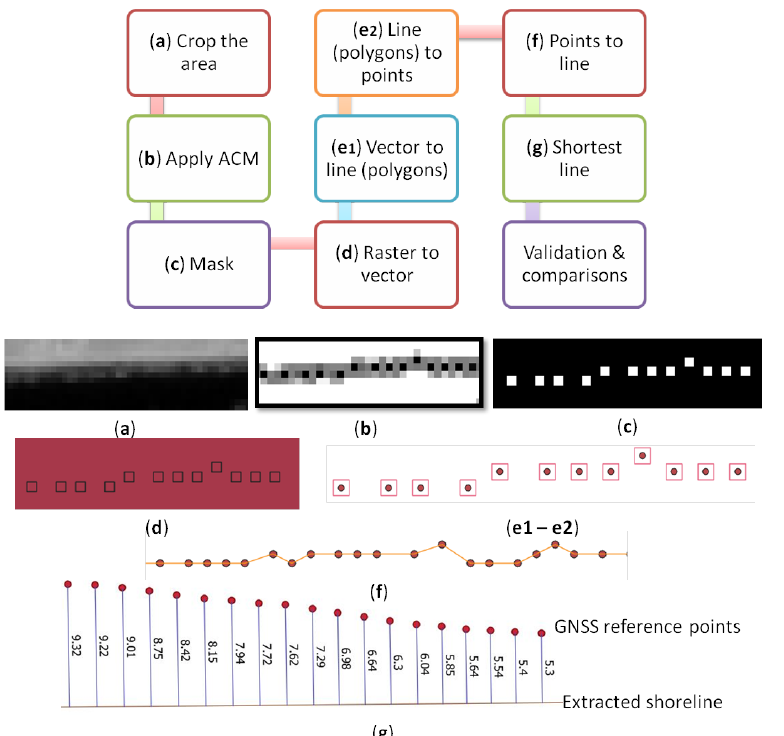
Figure 4. Semi-automatic methodology for shoreline extraction: ( a ) crop of the original NIR band image; ( b ) J-Net Dynamic application; ( c ) mask of pixels with the same value; ( d ) transformation from raster to vector and ( e1 ) from vector to line, which are polygons around every pixel, and ( e2 ) from line (polygons) to points; ( f ) interpolation to create the final shoreline; ( g ) computation of the shortest distance between extracted line and GNSS measurements (the measures are expressed in